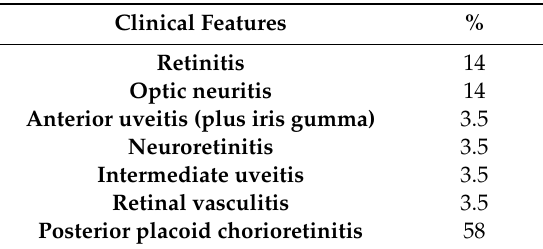
Table 1. Syphilis clinical features.